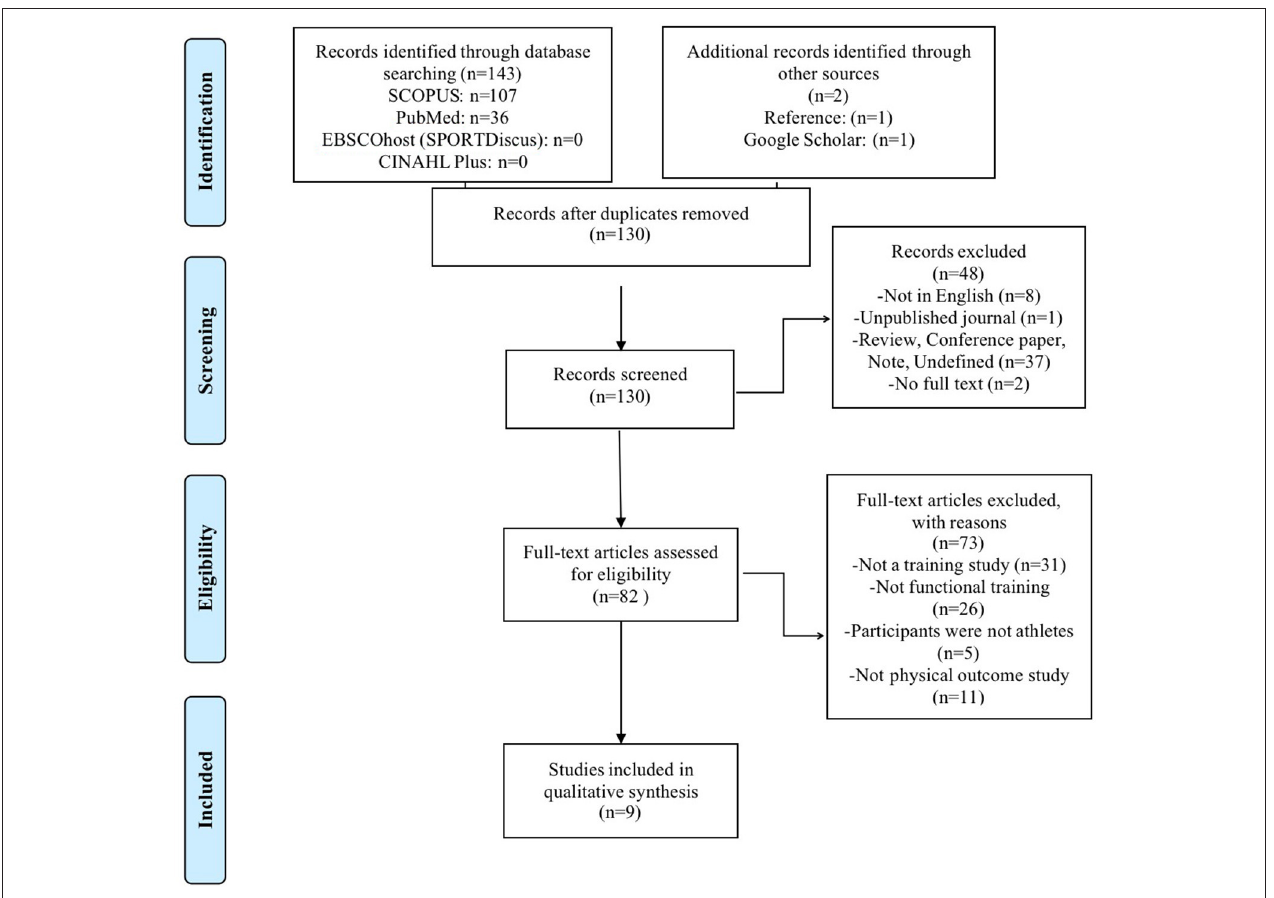
FIGURE 1 | PRISMA flow chart of the study selection